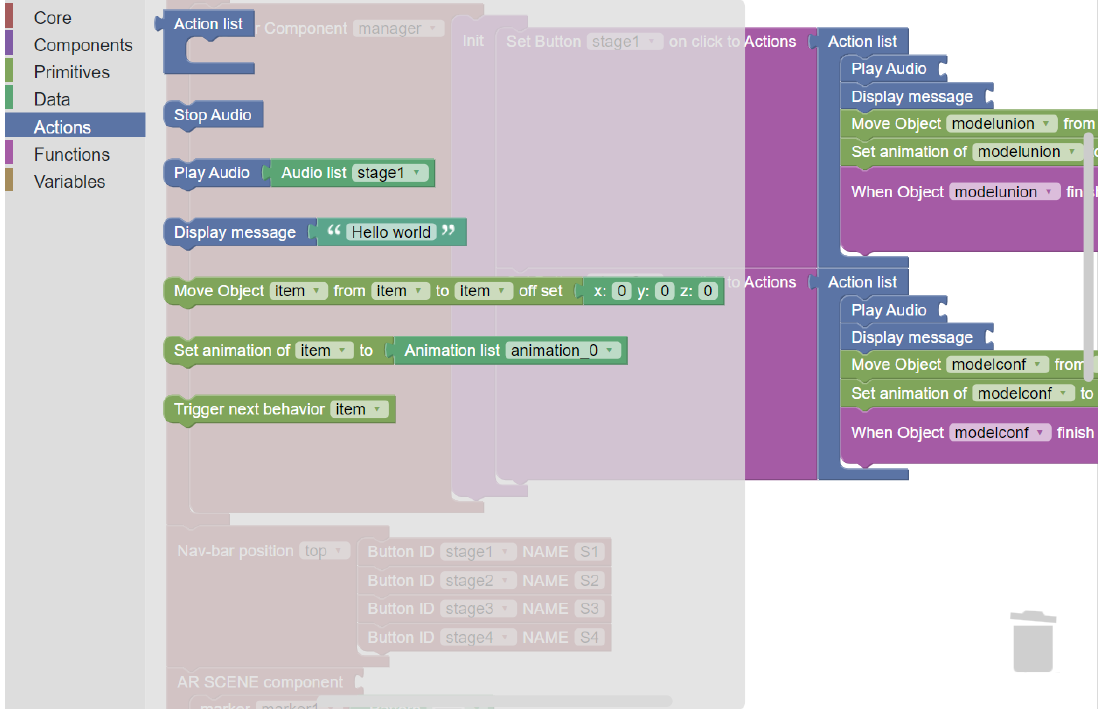
Figure 4. The coding editor of BlocklyAR enables users to drag and drop a palette of commands into the working